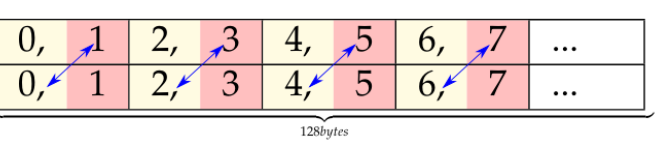
Figure 11. Virtual elements shuffle.